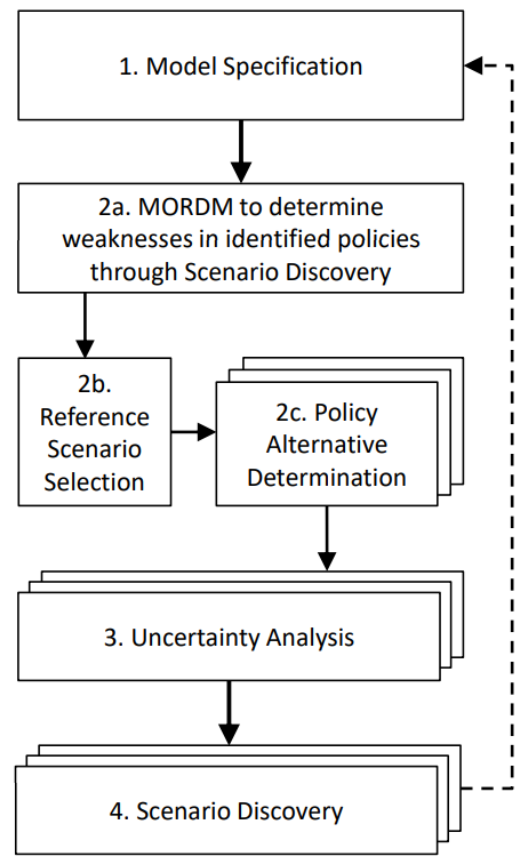
Figure 5. Extended MORDM Process as Introduced in [50].